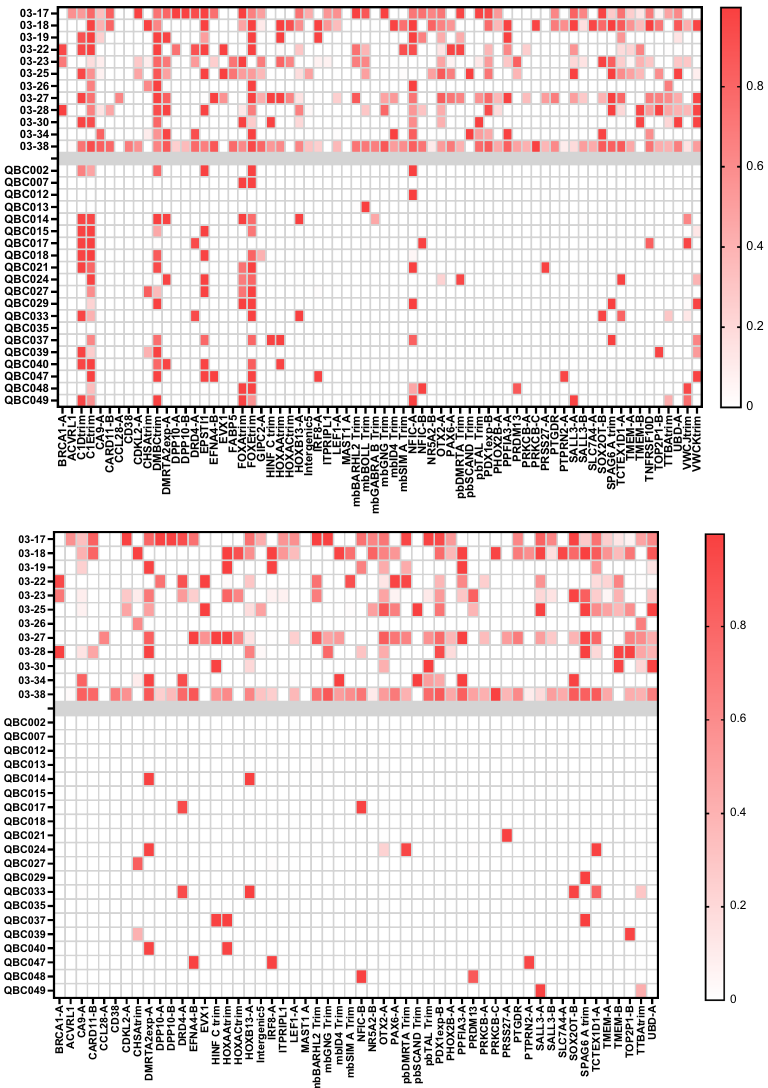
Fig. 6 Test cohort. Twelve plasma samples from Cohort 03 patients and 20 plasma samples from healthy age-matched volunteers (QBC 002- 049) were analysed for mDETECT as described in Fig. 5 and a heatmap of the fraction of methylated DNA for each probe is shown. (Top) The original 68 probes set is shown. (Bottem). Probes were removed based on the presence of 3 or more positive probes in the controls to leave 54 poorly 49,50 . In Cohort 03, 8 women (out of 29, 28%) who were negative for CA15-3 (<30 units/ml) were positive for mDETECT, and similarly in the CRB cohort 5 women (out of 30, 17%) who were negative for CA15-3 were positive for mDETECT (Fig. 10). A number of these patients who were CA15-3 negative had high levels of ctDNA as measured by both mDETECT and TP53 mutation assays. mDETECT is somewhat correlated with CA15-3